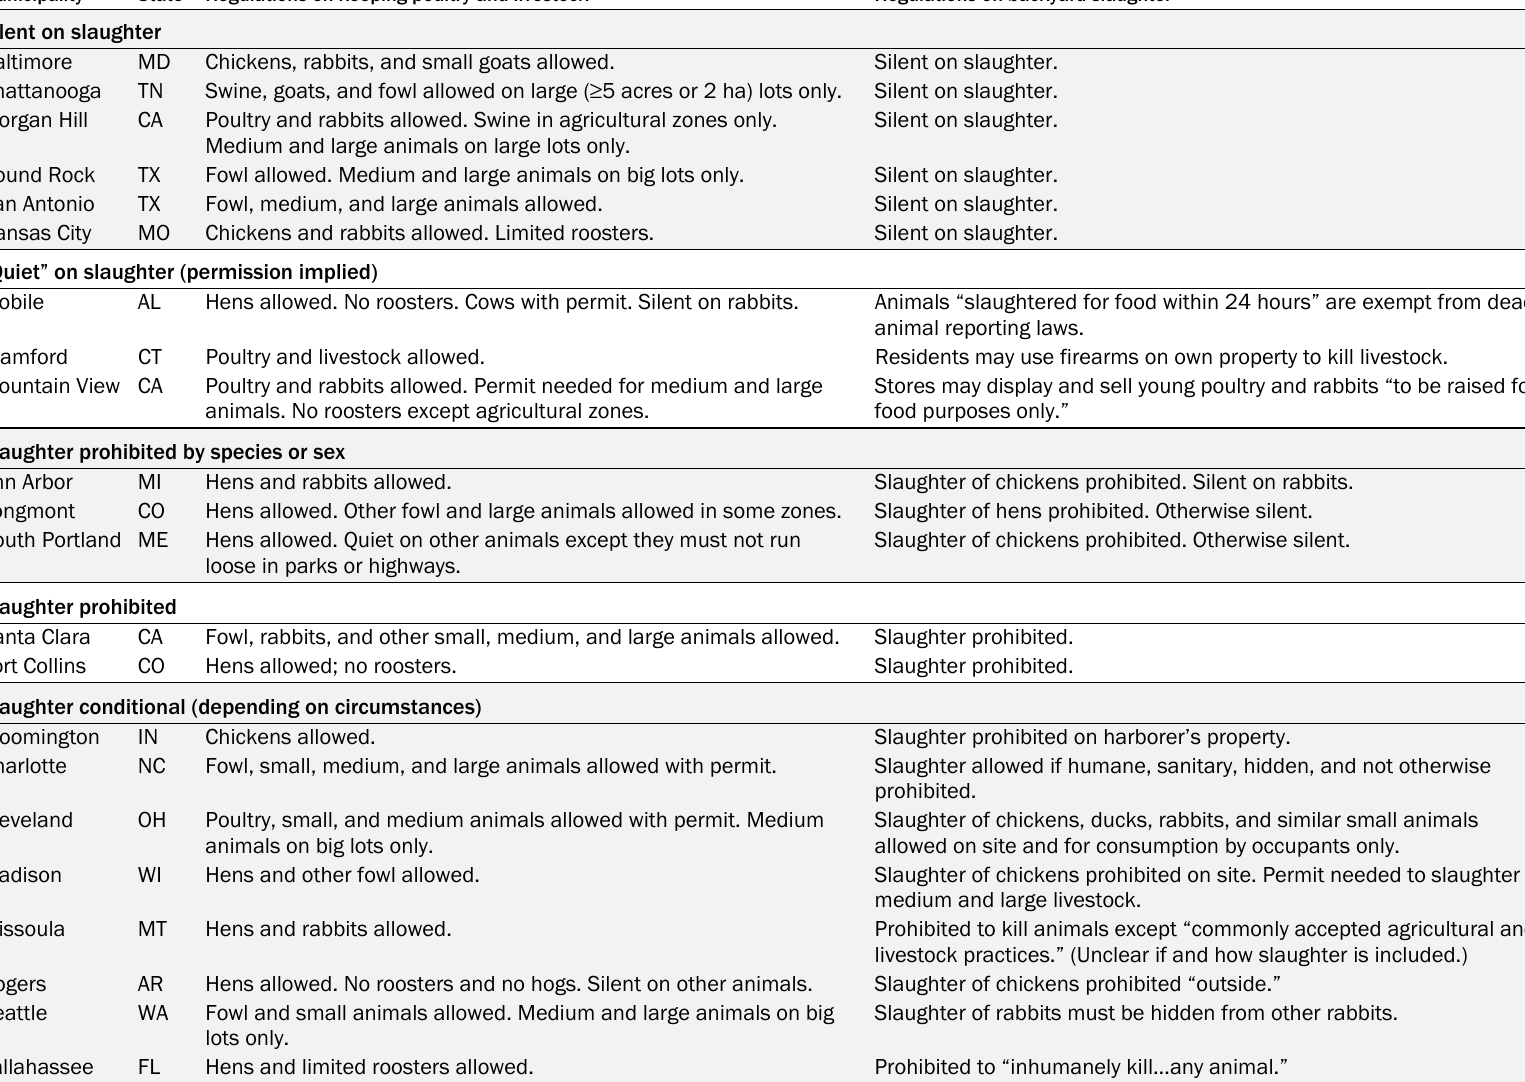
Table 2. Five Approaches To Regulating Backyard Animal